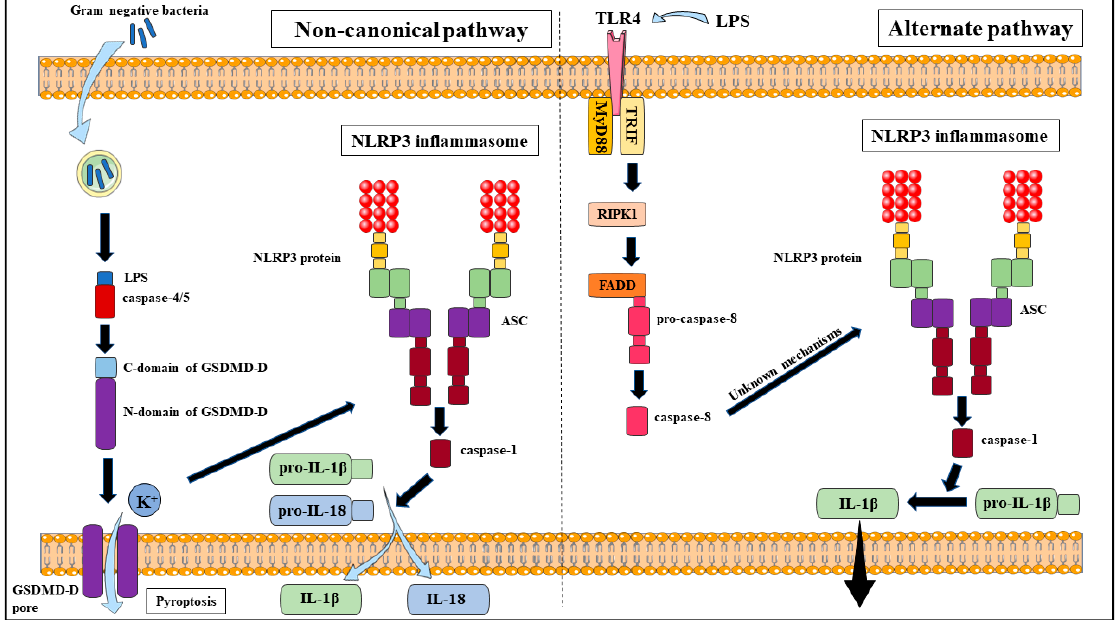
Figure 2. Non-canonical and alternate activation pathways of NLRP3 inflammasome .